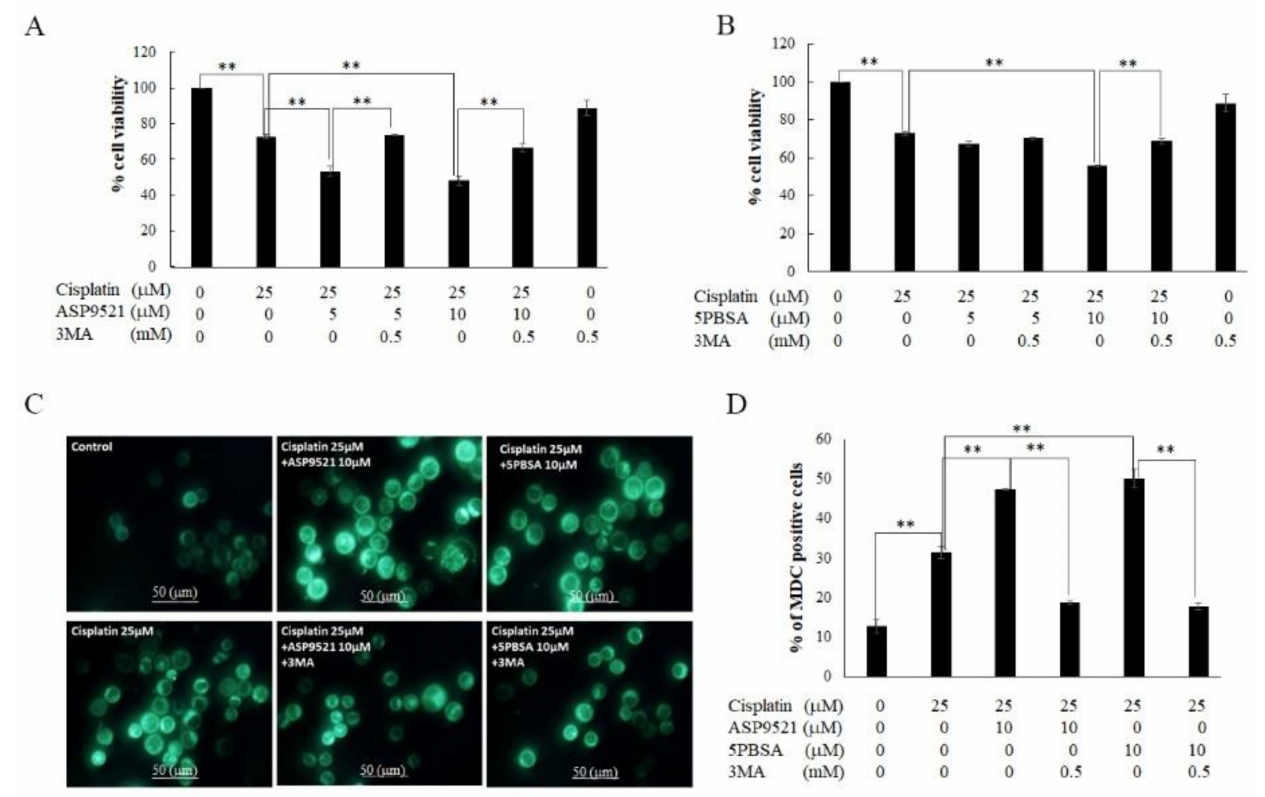
Figure 8. Verification of autophagy as a major pathway of AKR1C1- and 1C3-regulated cell death. ( A ) KATO/DDP cells were treated together with cisplatin and ASP9521 with or without 3MA at 0.5 mM. Cell viability was assessed by using trypan blue cell exclusion assay. ( B ) KATO/DDP cells were treated together with cisplatin and 5PBSA with or without 3MA at 0.5 mM, and cell viability was assessed by using trypan blue cell exclusion assay. ( C ) KATO/DDP cells were treated together with cisplatin and ASP9521 or 5PBSA at 10 µ M with or without 3MA at 0.5 mM. Autophagic vacuoles were stained with MDC dye and visualized under fluorescent microscope. ( D ) Graphical representation of % of MDC-positive cells in KATO/DDP. Data are presented as mean ± SD; ** represents p <